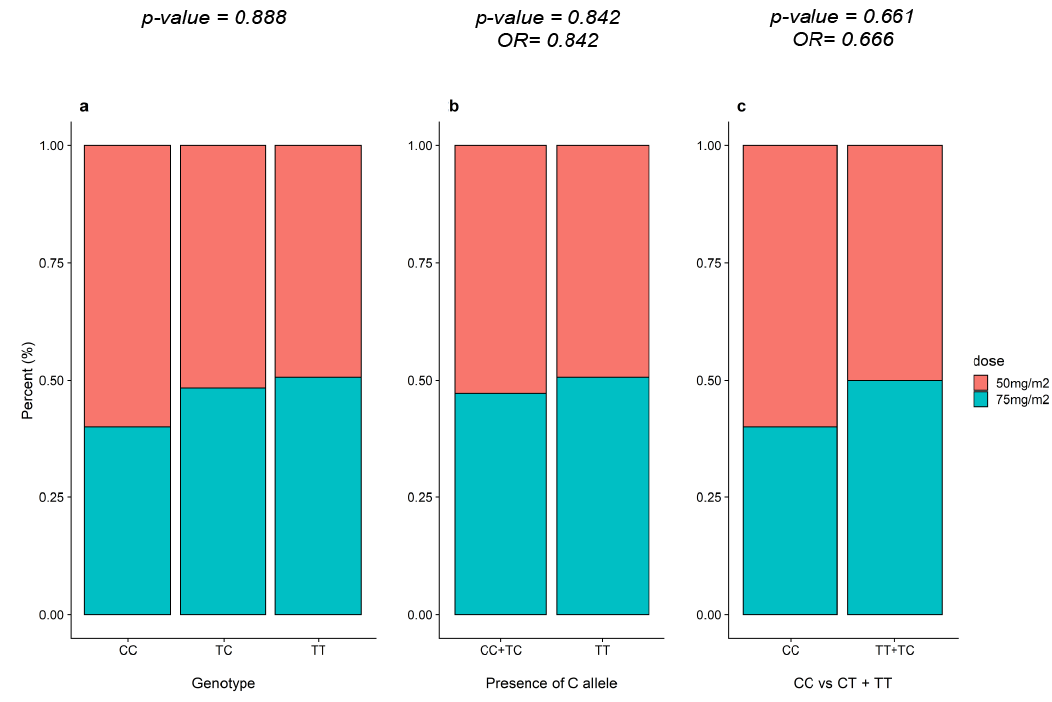
Figure 2. Distribution of TPMT_rs1142345 variants according to the 6-MP dose used in the maintenance phase of the ALL treatment ( a ) between carriers and non-carriers of the C allele ( b ) and among patients with genotype CC vc CT + CC ( c ).